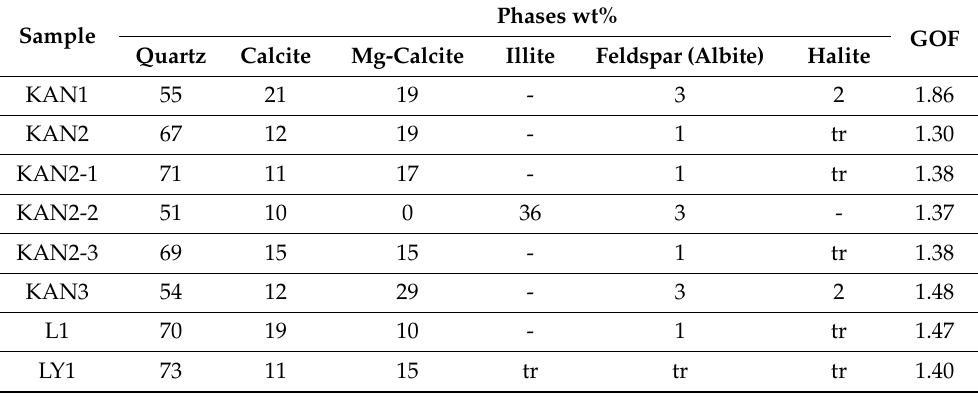
Table 1. Semi-quantitative mineralogical results of studied samples (error of each phase <1; GOF: Goodness of fit; tr: